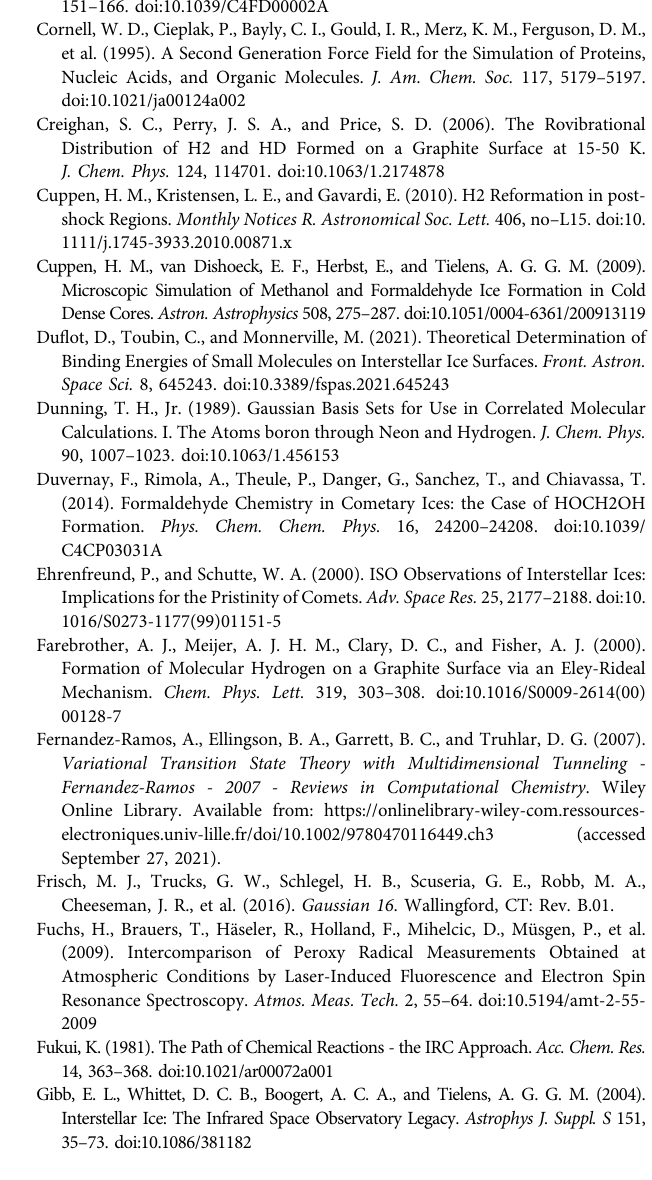
Supplementary Table S2 | Complete calculated reaction LH rate constants in s -1 for H 2 formation on the grain model at CBS level. Supplementary Table S3 | Calculated absolute energies